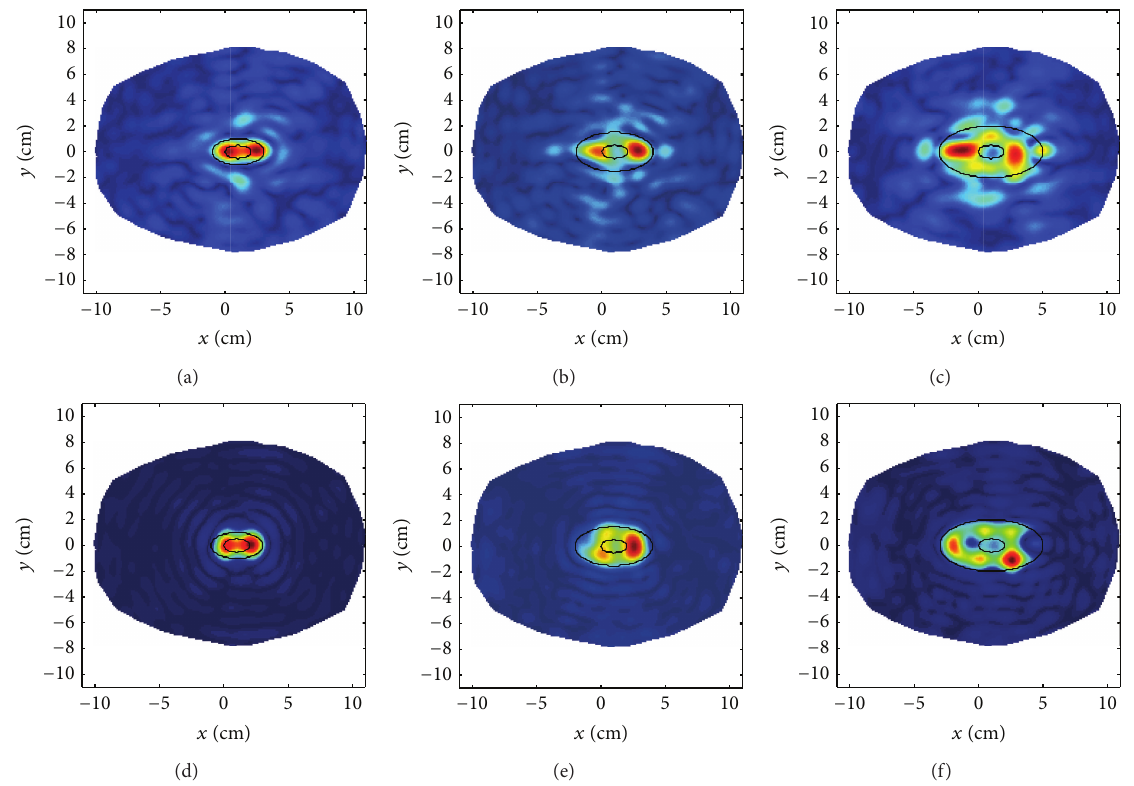
Figure 3: Assessment of the role played by patient specific information on the proposed TSVD imaging approach: (a)–(c) time evolution of an ischemic stroke when a nonspecific reference head model is adopted; (d)–(f) the same as (a)–(c) but using an accurate reference scenario in the inversion. The images report the normalized amplitude of the differential contrast as retrieved from (4), so that red areas mark the portion of the head where main changes are occurring. In all cases noiseless data have been